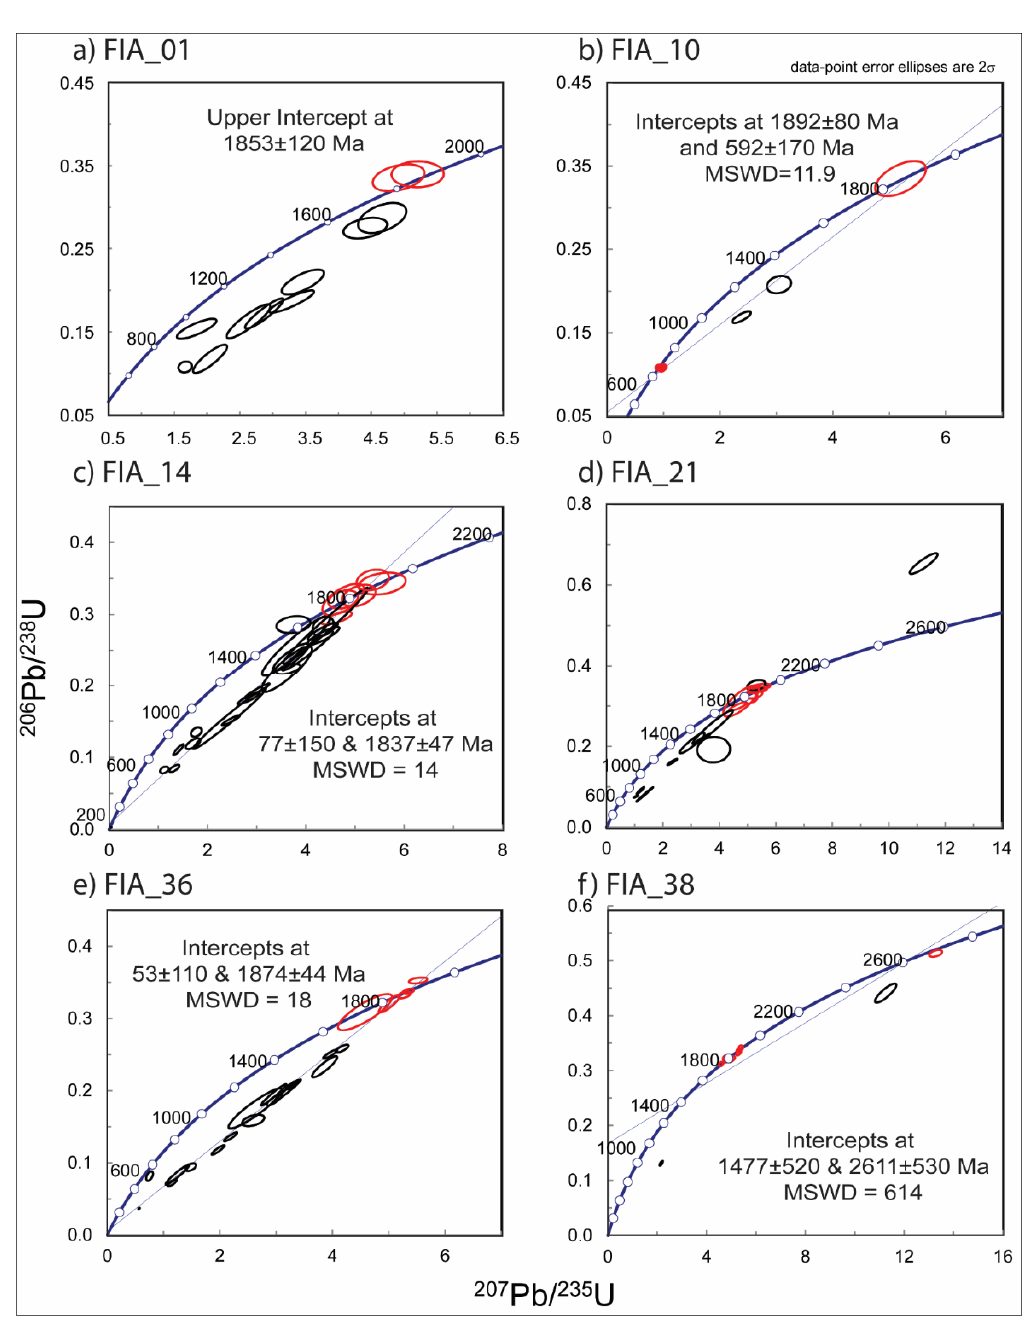
Figure 5. U-Pb Concordia plots. ( a – f ) U–Pb concordia plot for basal diamictite samples overlying the Carrapateena deposit. Sample locations are shown in Figure 1b.